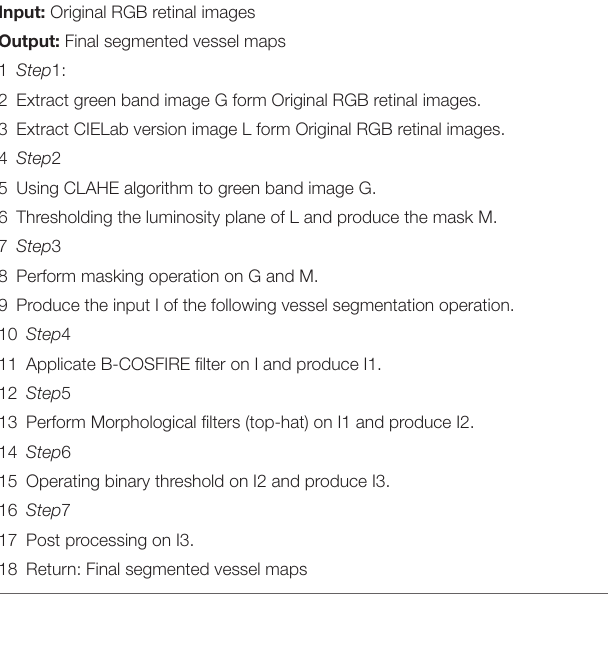
Algorithm 1 | B-COSFIRE vessel segmentation